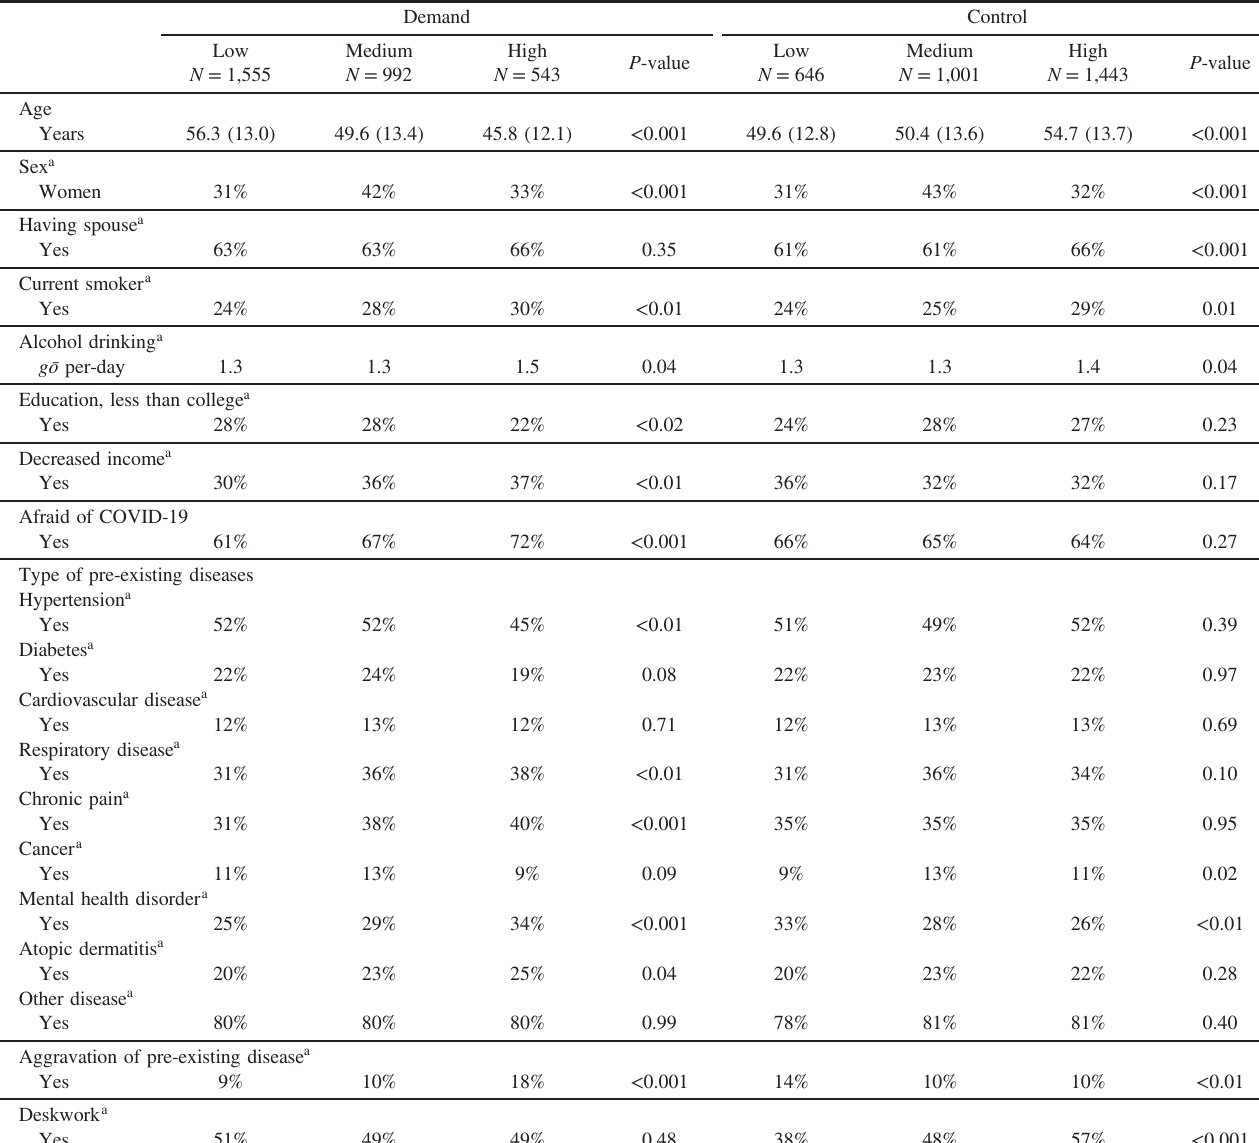
Table 1. Characteristics of participants by demand and control